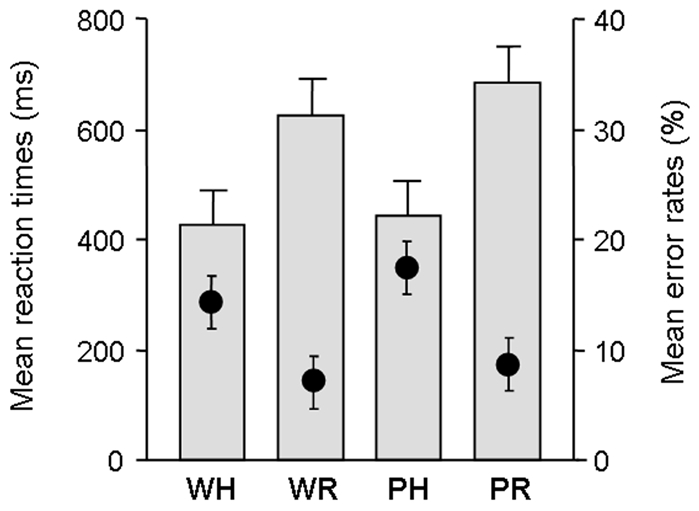
Behavioral results.W refers to Words, P to pseudowords (lexical category under focus), H to Hold and R to Release (sustained attention). Mean reaction times are depicted by histograms and mean error rates are depicted by circles. Error bars indicate standard errors. The reference time for reaction time values is the onset of the stimulus of the pair which has induced the participant's answer, i.e. the onset of the first stimulus of the pair in the ‘release’ condition and the onset of the second stimulus in the ‘hold’ condition.